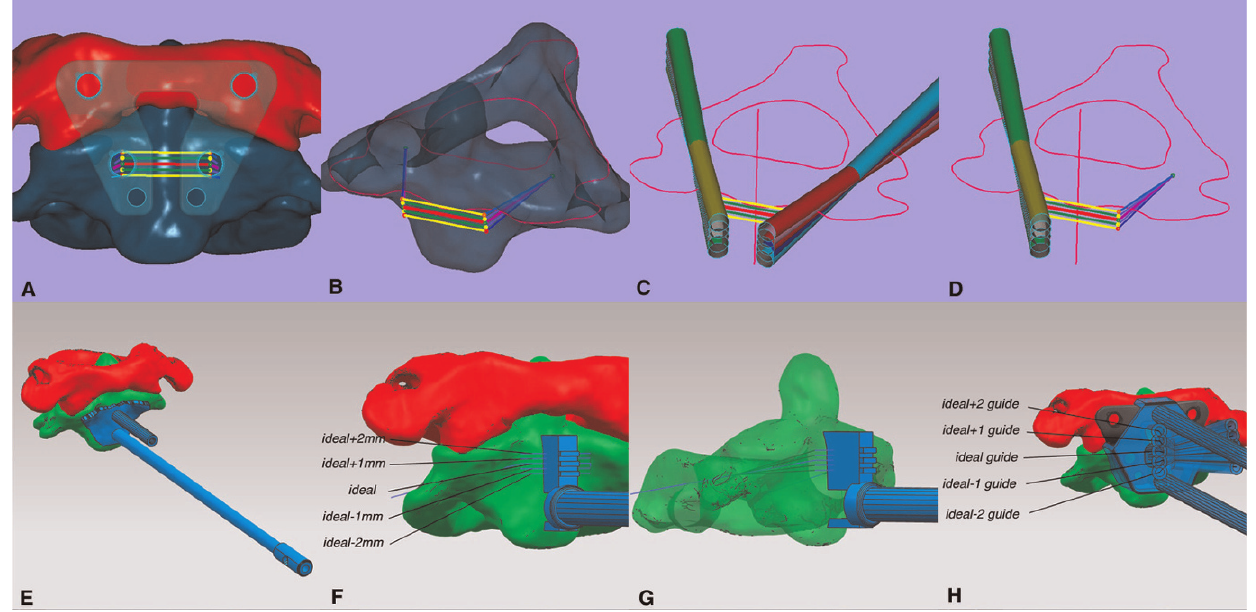
Figure 3 - A diagram showing the strategy of the template design. A Anterior view (the TARP-IV was situated at the ideal position). The green points: ideal screw entry points; the yellow points: 1 mm above or below the ideal screw entry points; the red points: 2 mm above or below the ideal screw entry points. B Anterolateral view. The two green points behind the possible screw entry points are the ideal screw passing points in the bilateral pedicles of C2. C and D The relationships between the possible screw trajectories and the contour of C2. E The positioning of Template A. F The positioning of Template B and the designing line graph (anterior view). G The positioning of Template B and the designing line graph (lateral view). H The positioning of Template C to the C1 and C2 anterior surfaces and the relationship between Template C and the TARP-IV.